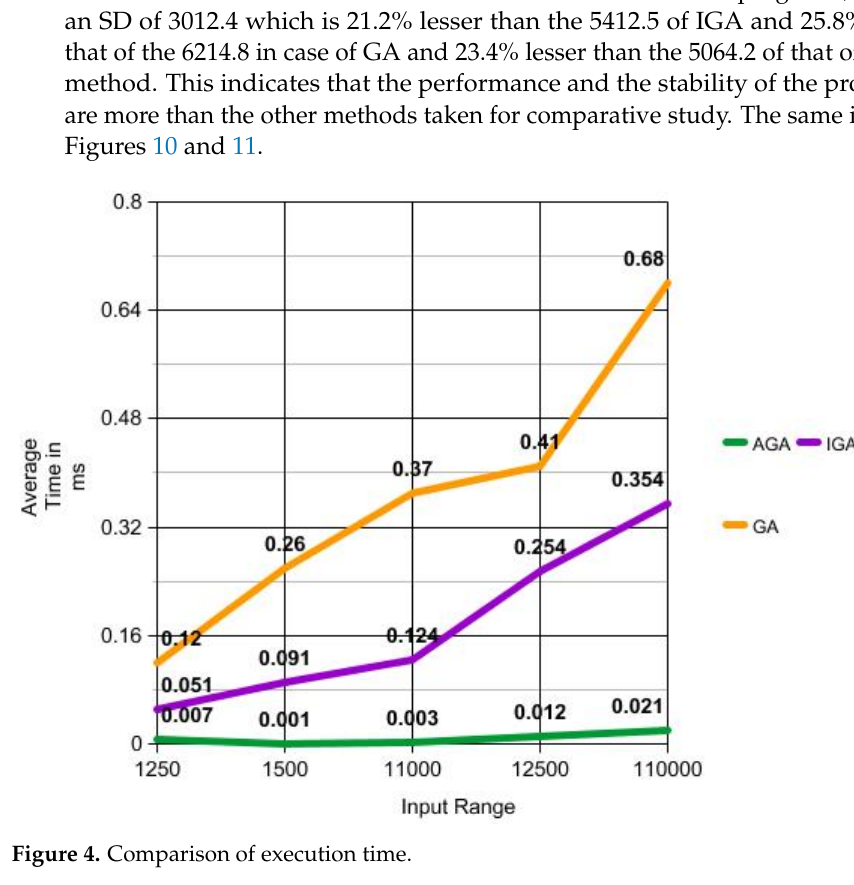
Figure 4. Comparison of execution time.